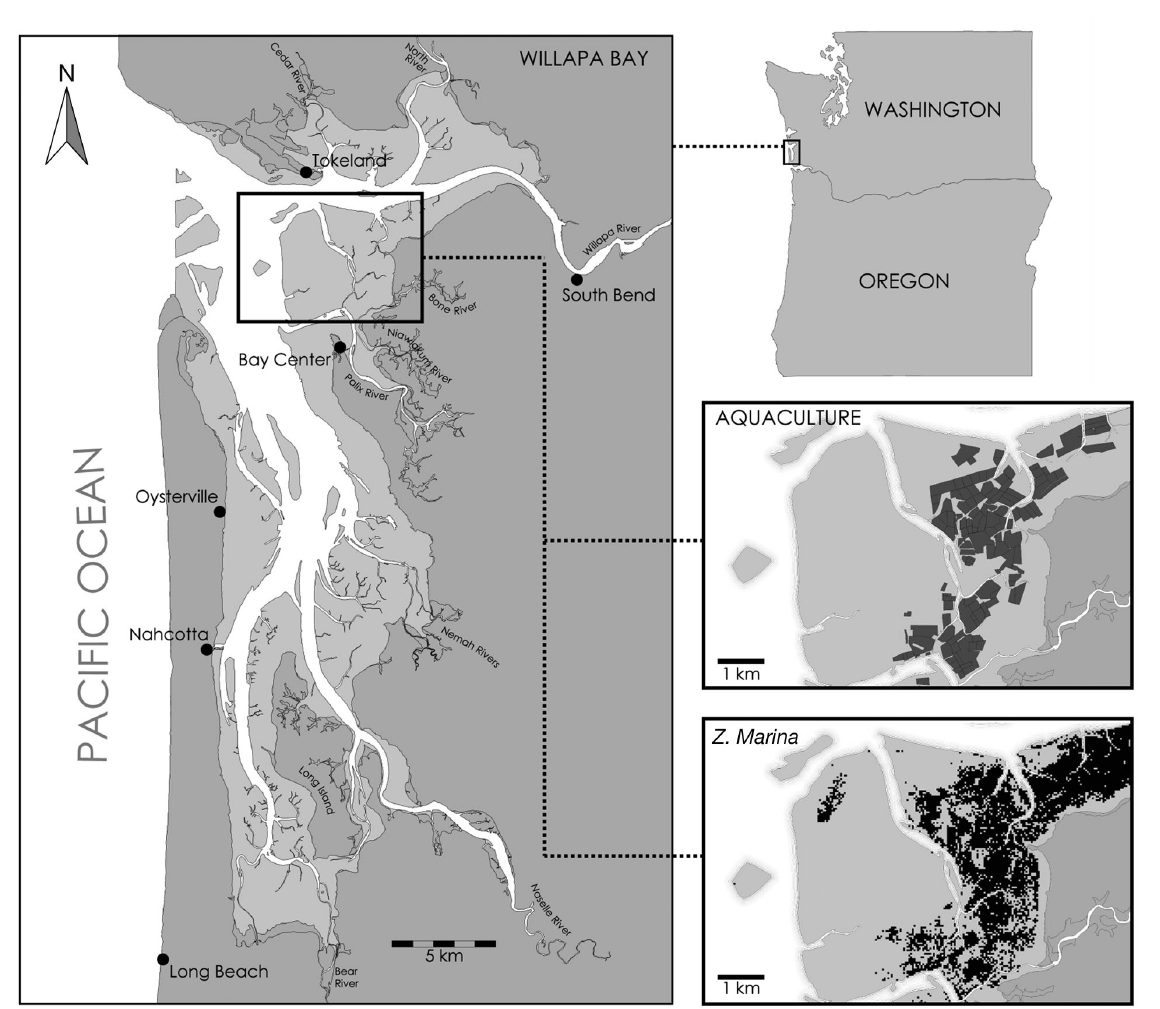
Fig. 1. Willapa Bay estuary. Note large intertidal area of the estuary (62%, light gray). Insets—top right: location in Washing- ton State, USA; middle and lower right: shellfish aquaculture beds (dark grey) and eelgrass Zostera marina (black) distribution in 2005 in a northeastern portion of the